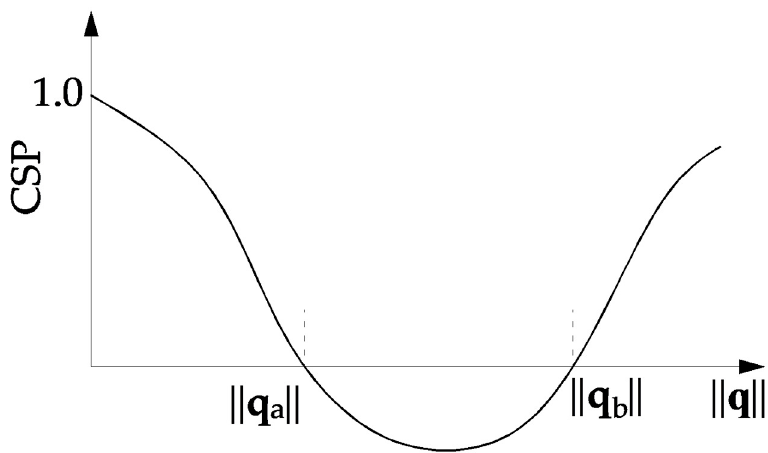
Figure 2. Dependence of CSP parameter on the norm || q ||.